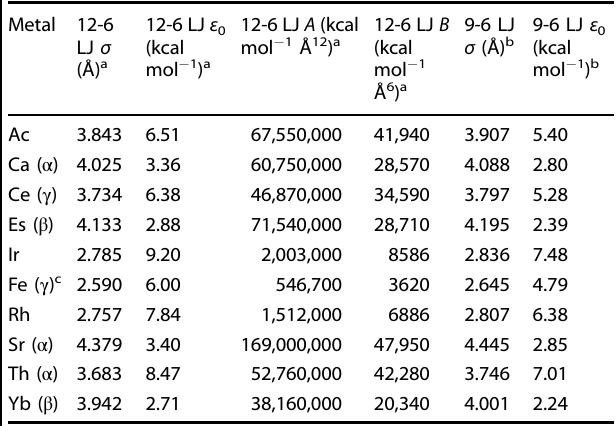
Table 1. 12-6 and 9-6 Lennard – Jones parameters for 10 fcc metals, including non-bond diameters σ and well depths ε 0 , as well as constants A and B (in case of 12-6 LJ